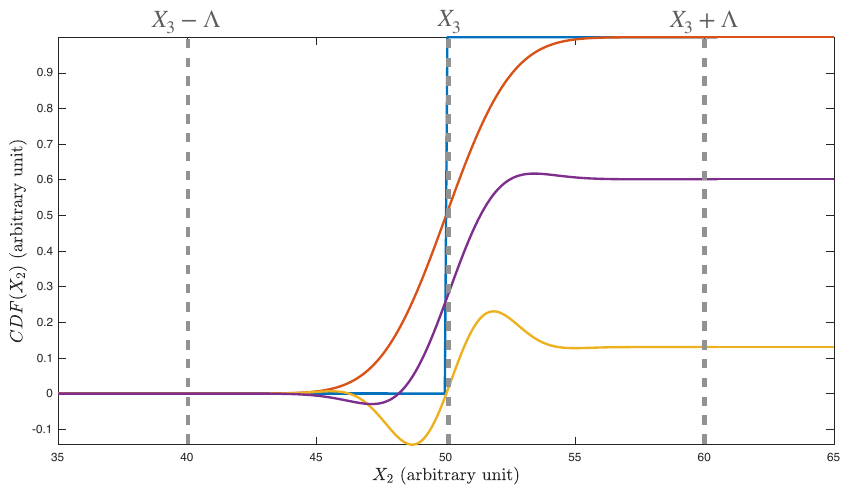
Figure 19 . The cumulative distribution function (CDF) of Y ( X 2 ; X 3 = 50) as a Gaussian PDF with width = 2 AU (arbitrary units of X delta function centered at 50 AU for the blue line; and N ( X yellow/purple line; Λ is the cutoff value in eq.